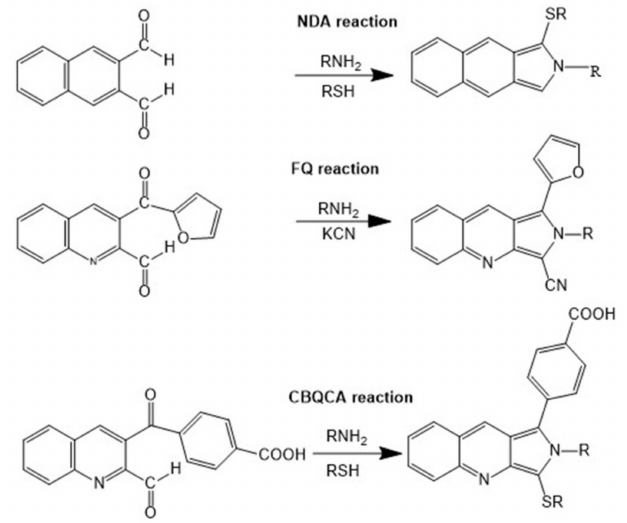
Figure 1. Chemical structures and labeling reactions of naphthalene-2,3-dicarboxylaldehyde (NDA), 5-furoylquinoline-3-carboxyaldehyde (FQ), and (4-carboxylbenzoyl) quinoline-2-carboxaldehyde